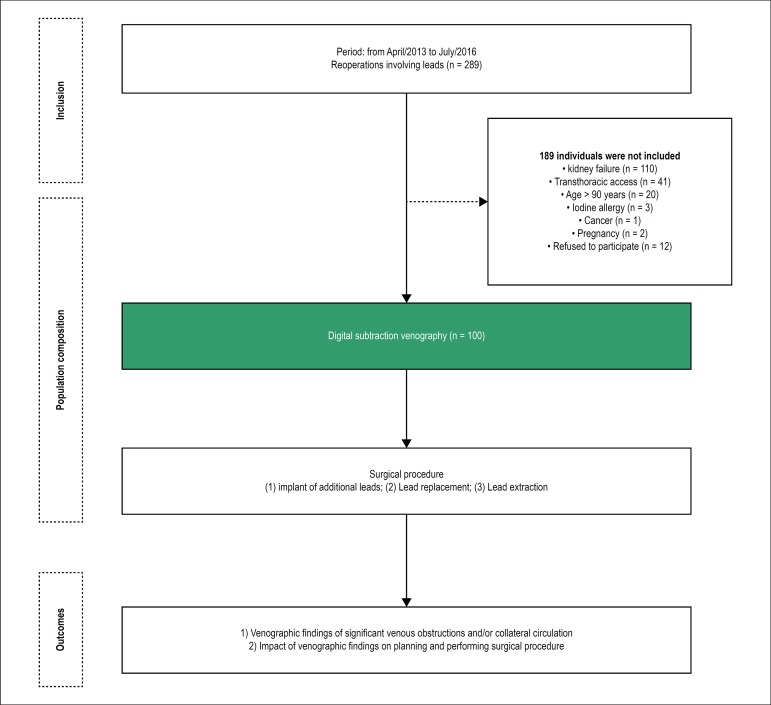
Composition of the population studied and Study phases.